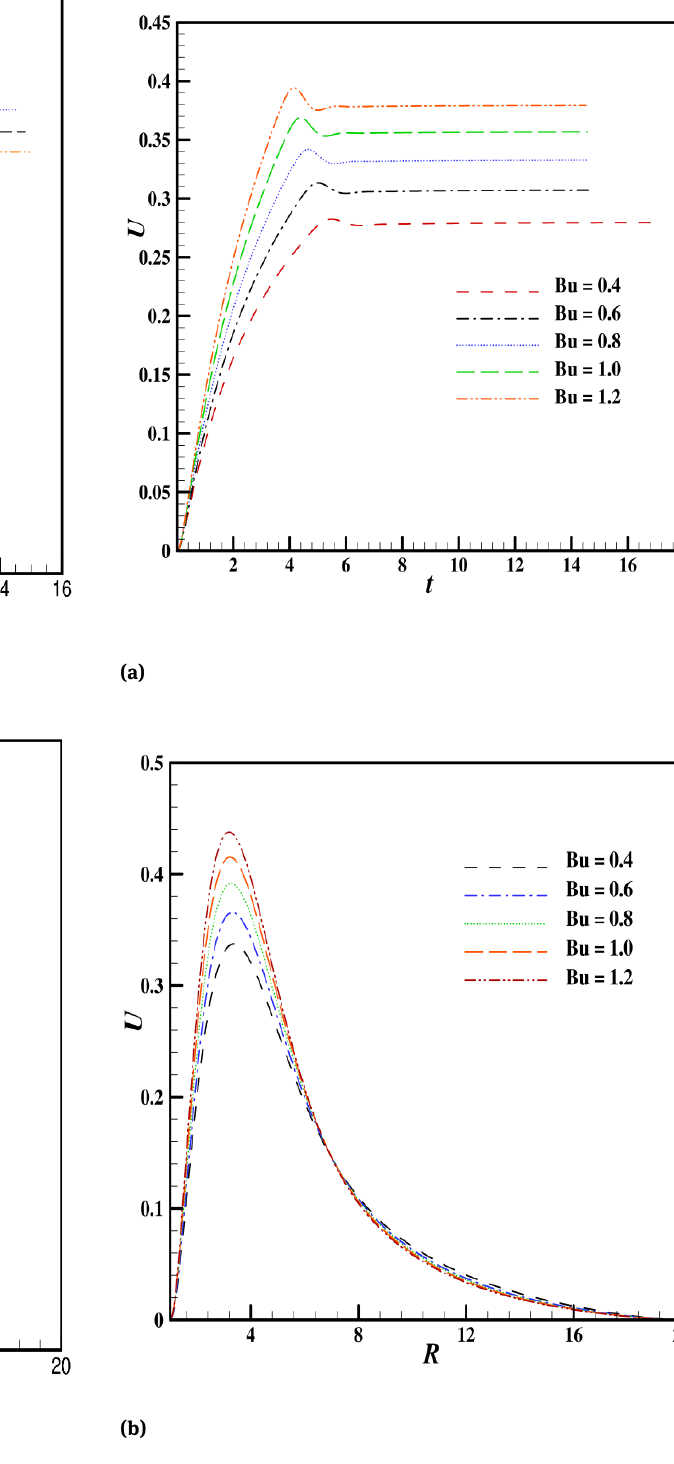
Figure 13: ( a ) Transient and ( b ) Steady state velocity profiles with fixed Sc = 0.6 , Pr = 0.7 , Kr = −0.2 , Nr = 1.0 , K 1 = 1.0 , M = 0.2 , Ec = 0.1